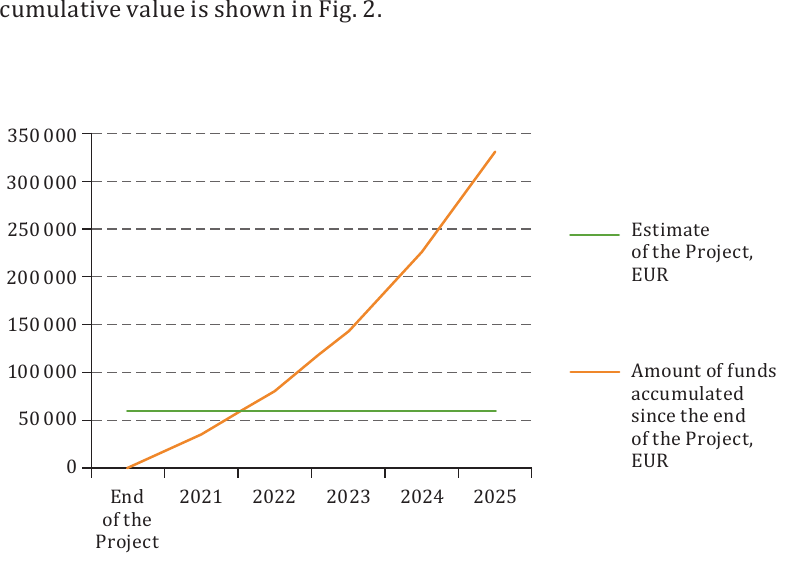
Figure 2. Project payback by accumulating earned income (created by the